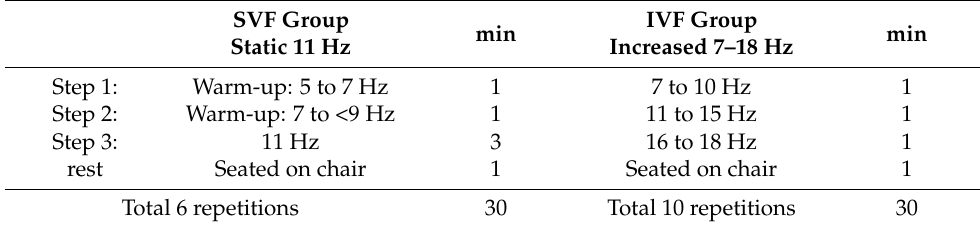
Table 1. Whole body vibration training